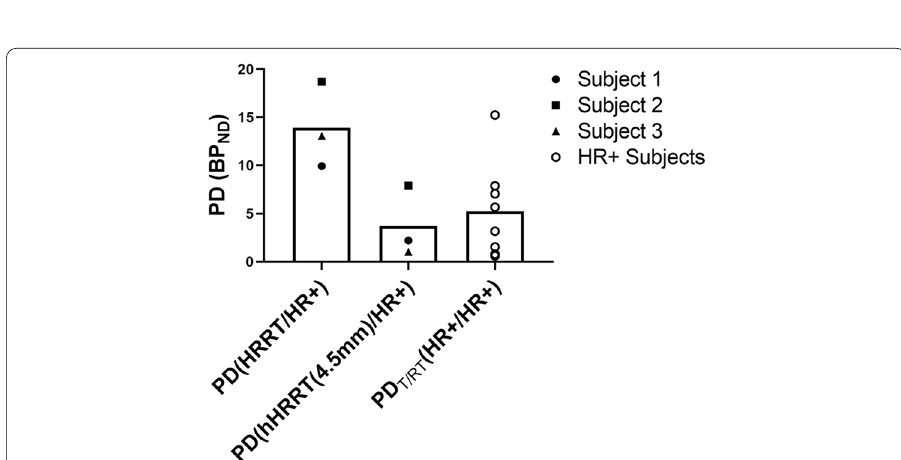
Fig. 5 Percent difference in striatal BP ND for the 3 subjects for HRRT and hHRRT (4.5 mm) relative to the HR compared with PD T/RT from 8 subjects scanned twice on the HR square), and Subject 3 (filled triangle) are all marked with filled shapes. The T/RT subjects are marked with open circles (open